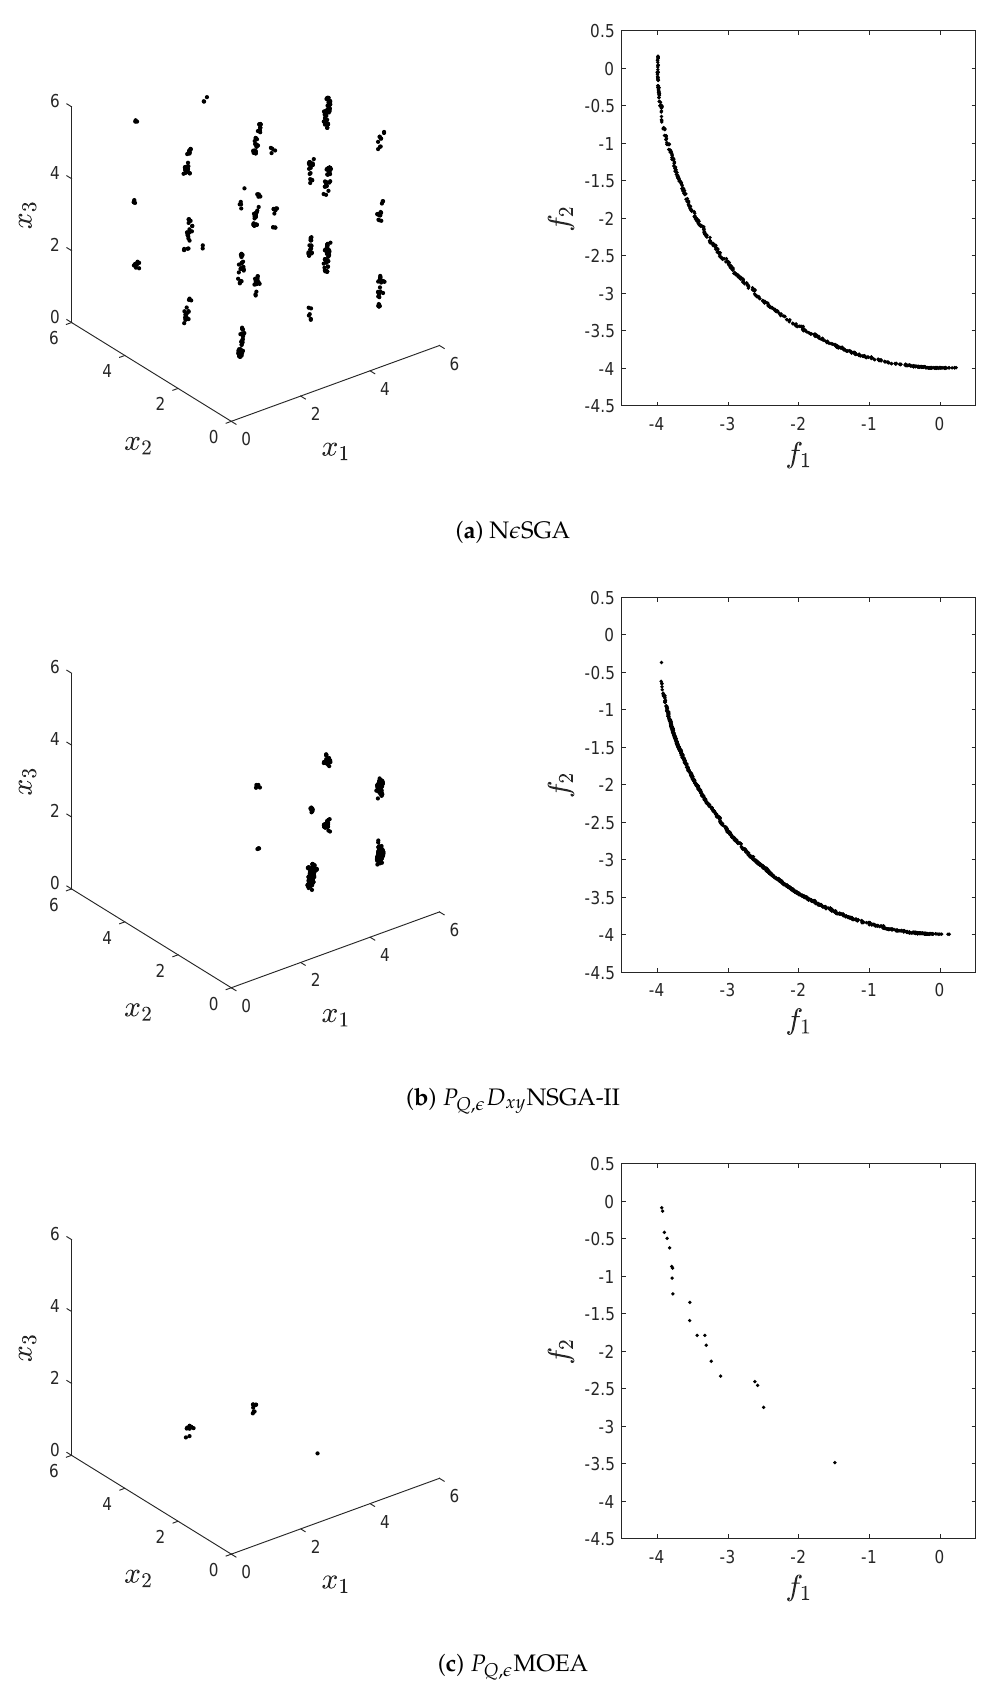
Figure 6. Numerical results on Omni test for the comparison of N e SGA2 and the state-of-the-art algorithms.